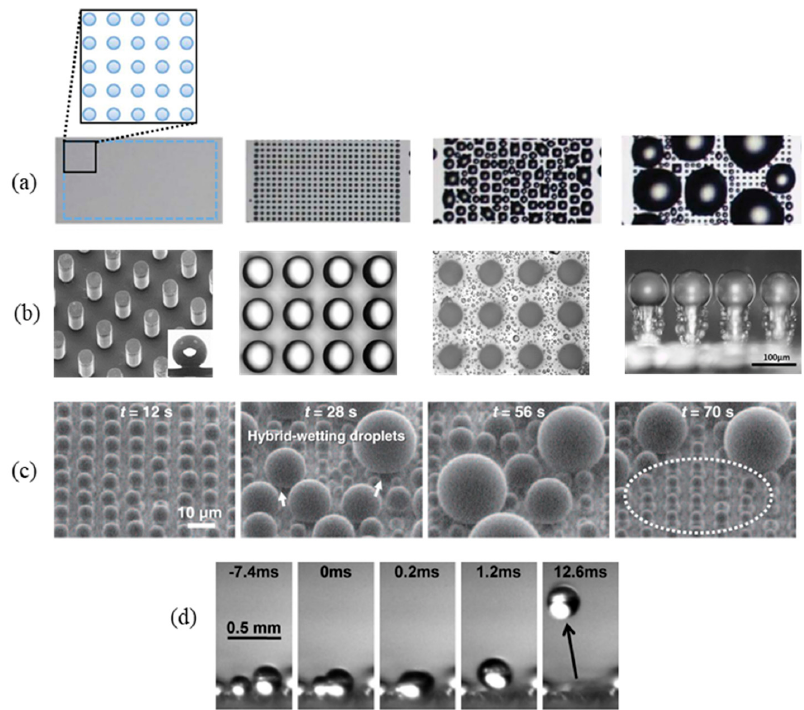
Figure 2. Microscopic condensation dynamics on various types of surfaces. ( a ) chemical patterned surface, Reprint from [21], Copyright 2016 with permission from Springer Nature. ( b ) topologically patterned surface, Reprint from [23], Copyright 2017 with permission from Elsevier. ( c ) biphilic surface with hydrophobic nanograss and hydrophilic micropillars. Reprinted with permission from [24],Copyright 2018 with permission from American Physical Society. and ( d ) spontaneous drop jumping upon coalescence, Reprinted with permission from [25],Copyright 2009 by the American Physical Society.